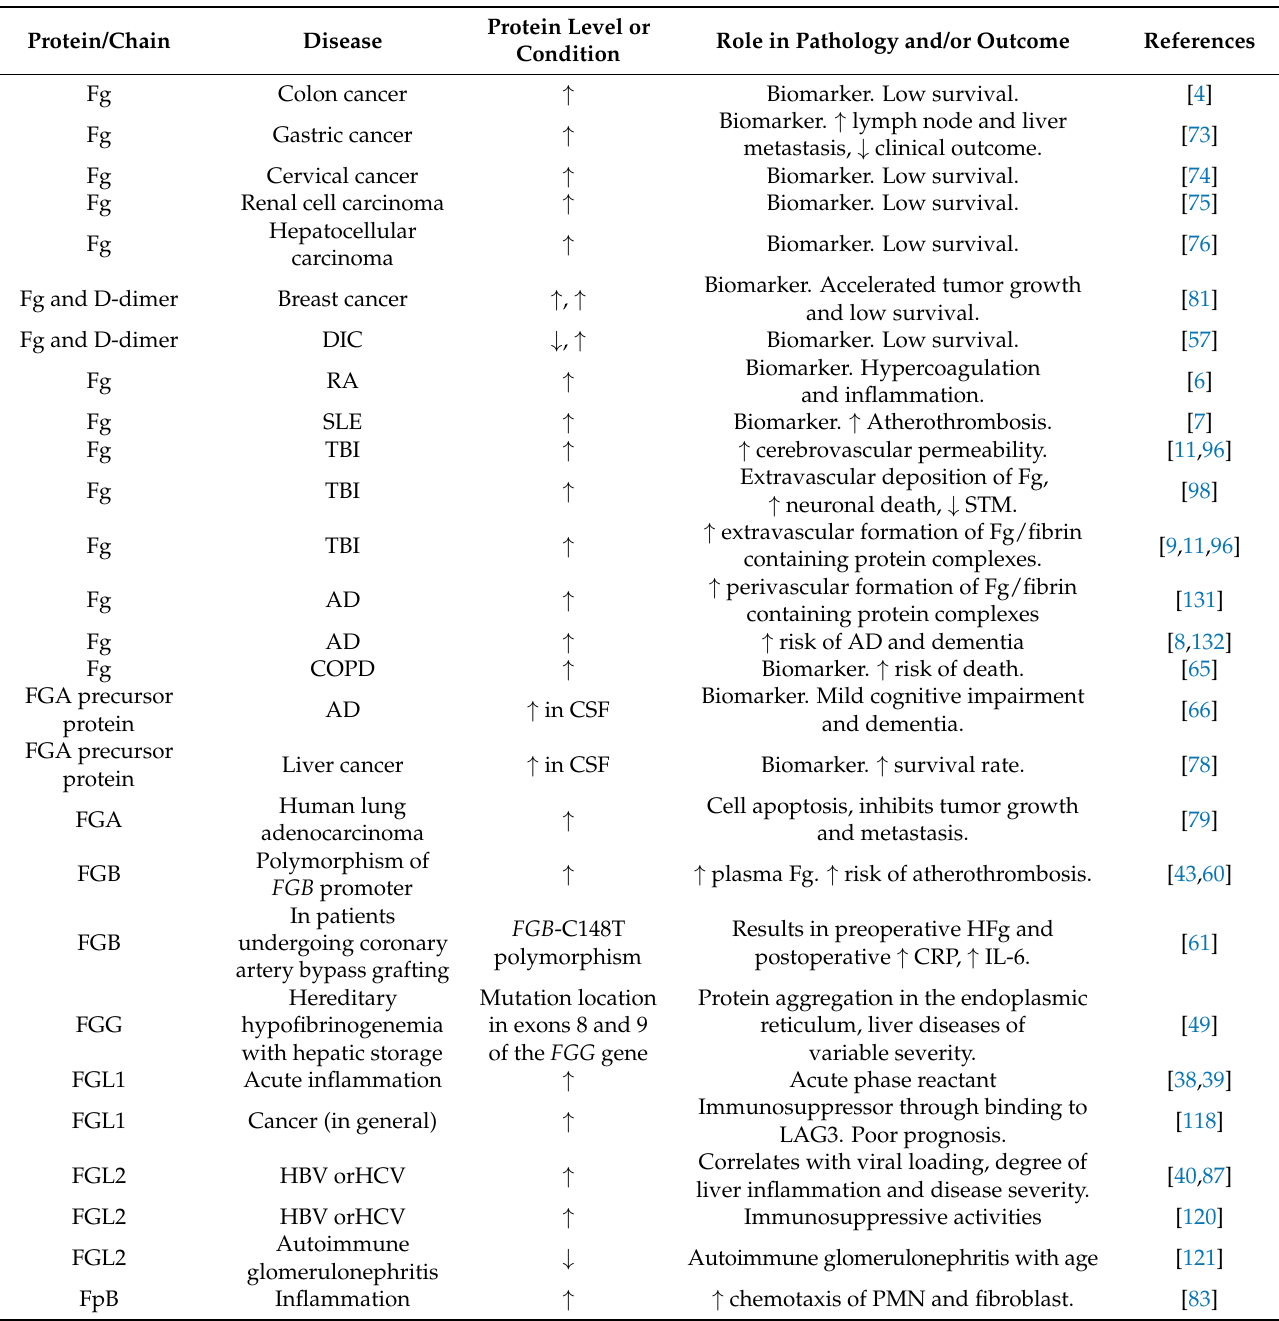
Table 1. Effects of fibrinogen/fibrin, fibrinogen chains, and fibrinogen-like proteins 1 and 2 during various